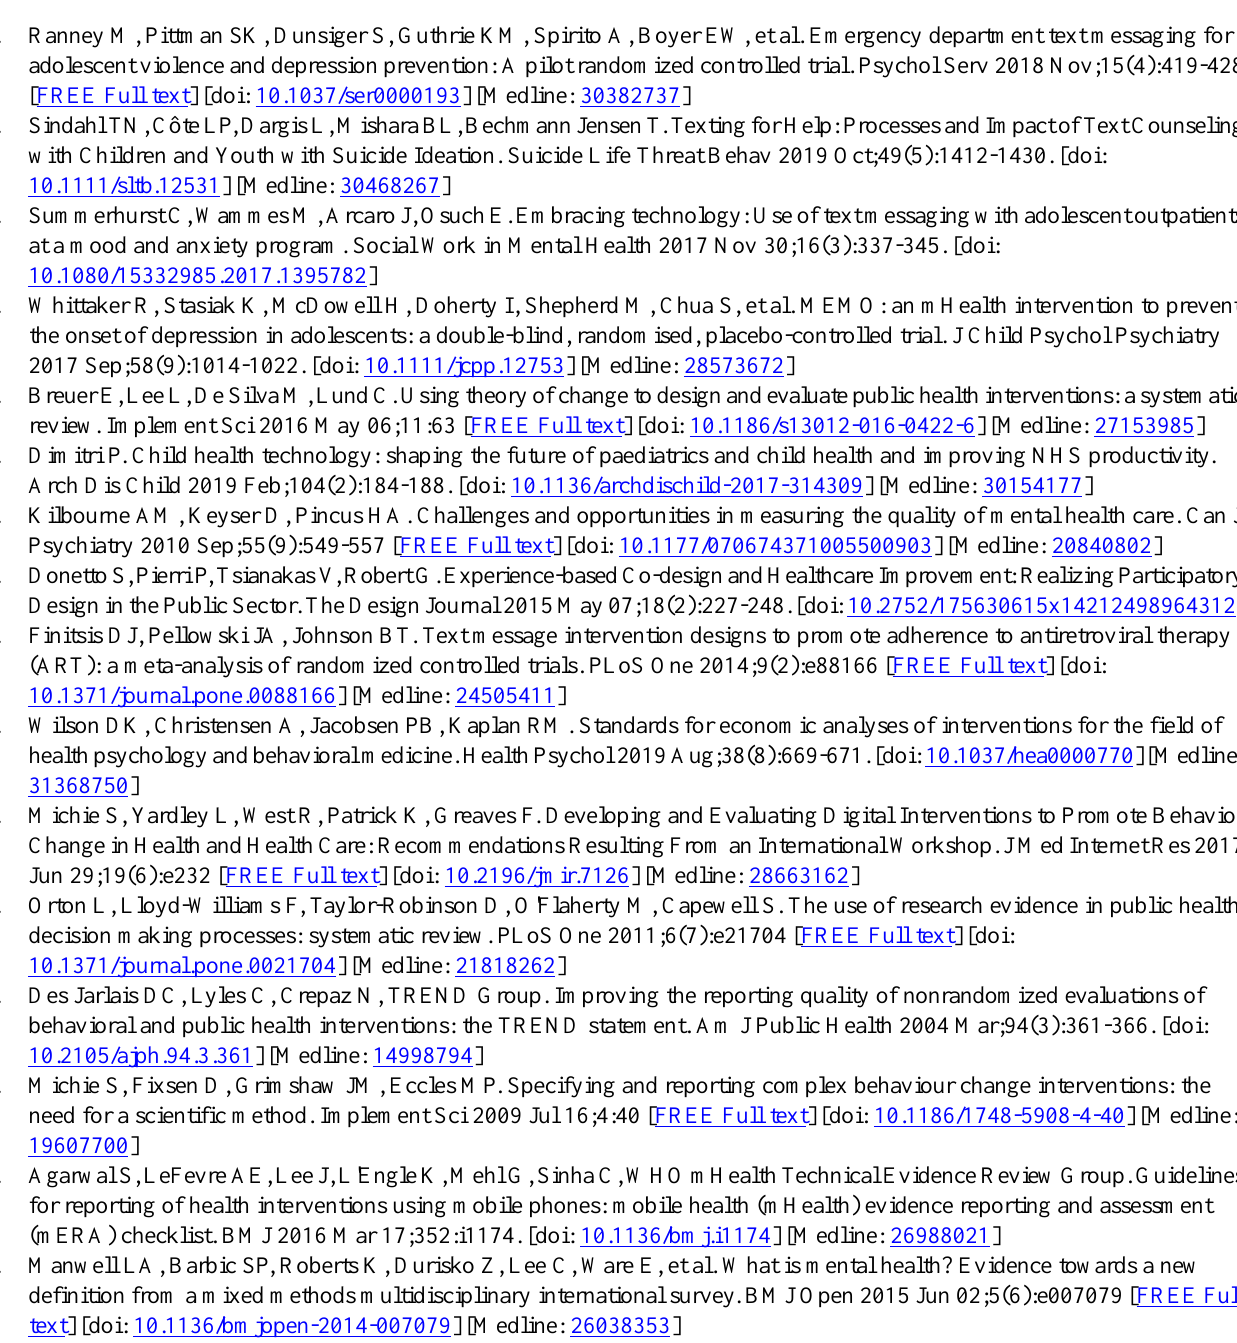
MSSU: Maritime SPOR SUPPORT Unit PRISMA: Preferred Reporting Items for Systematic Reviews and